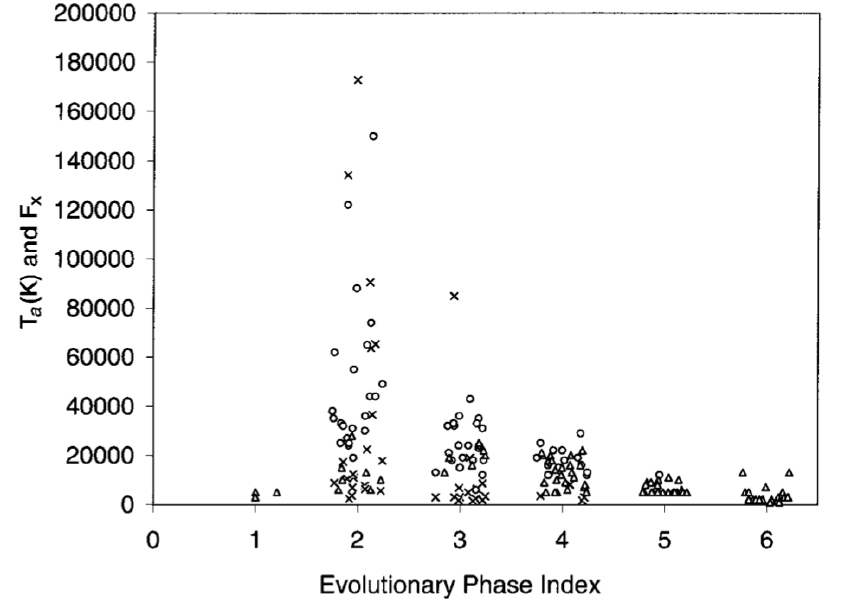
Figure 24: Microwave antenna temperature ( 𝑇 𝑎 (K)), and the X-ray flare index ( 𝐹 𝑋 ) plotted against the evolutionary phase index of the source regions. 𝑇 𝑎 (K), a measure received from a source by the radio telescope, is a proxy for brightness temperature of the source. The evolutionary phase index corresponds to: (1) emergence; (2) growth; (3) maximum development; (4) early decay; (5) late decay; (6) remnant. Symbols: ∘ – compact sources; △ – diffuse sources; x – X-ray flare index. Image reproduced with permission from Tapping and Zwaan (2001), copyright by